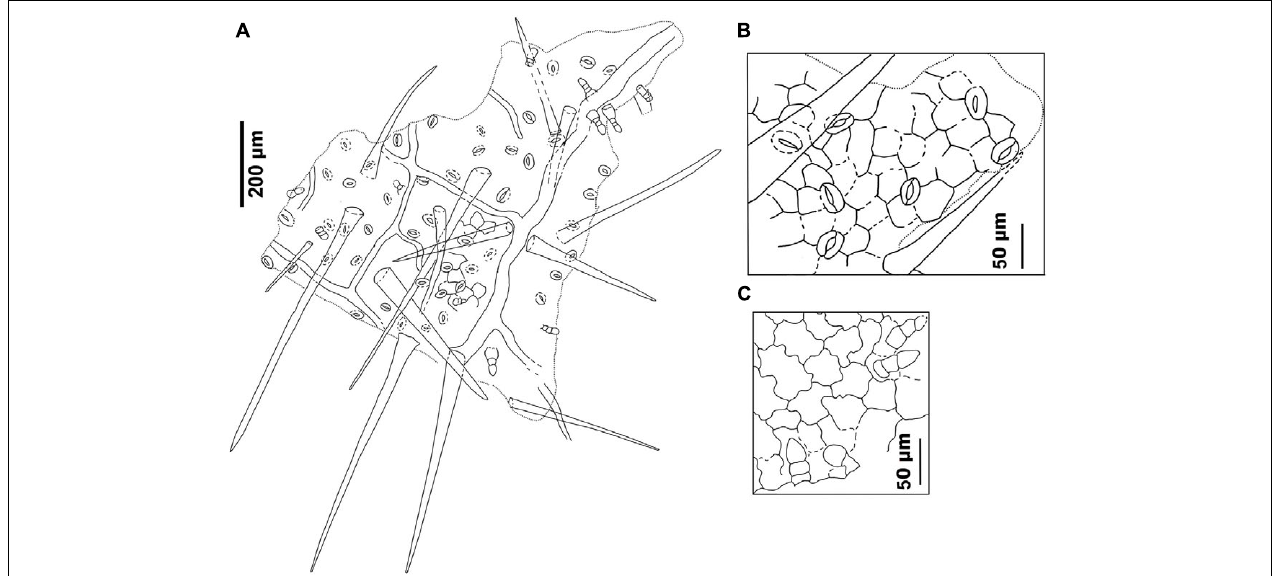
FIGURE 8 | Drawings of the leaf epidermal characters of M. eosinica sp. nov. from the Huangniuling Formation of the Maoming Basin, South China, MMJ3-837-3a. (A) Leaf abaxial surface showing stomata, long unicellular non-glandular trichomes, and multicellular glandular trichomes. (B) Higher magnifications of the abaxial surface. (C) Leaf adaxial surface showing glandular